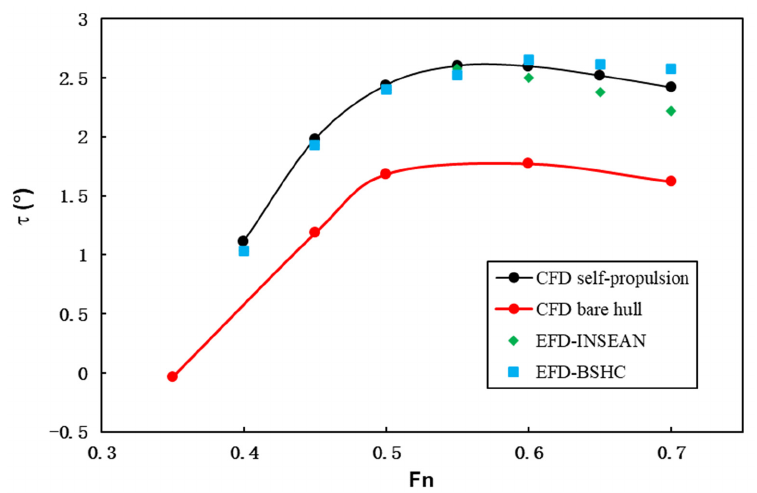
Figure 13. The comparison of trim between CFD and EFD results for self-propulsion